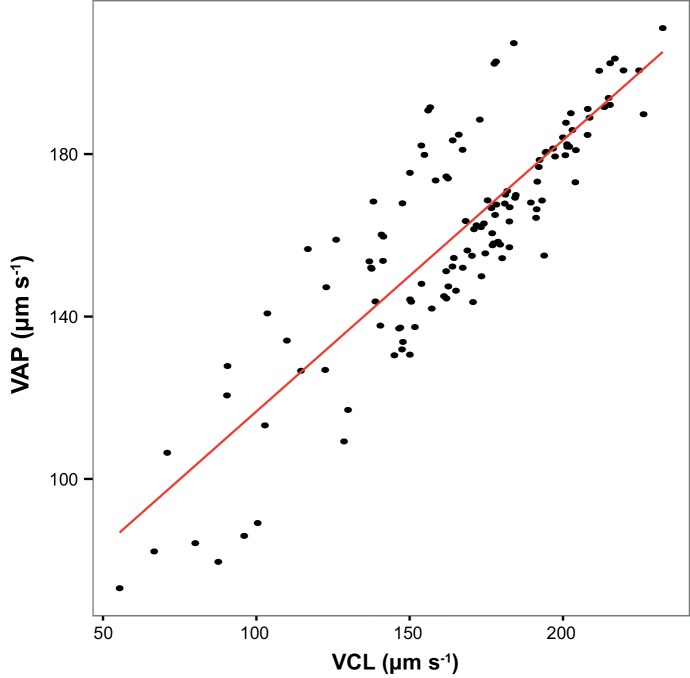
Across all sperm samples collected in this study, Average Path Velocity (VAP) at 10 s post-activation was strongly correlated with Curvilinear Velocity (VCL; r = 0.85, p<0.000 l, n = 126).10.7554/eLife.28811.008Figure 2—figure supplement 1—source data 1.Source data for correlation analysis.This Excel file contains the Average Path Velocity (VAP) and Curvilinear Velocity (VCL) data for all sperm samples collected in this study.